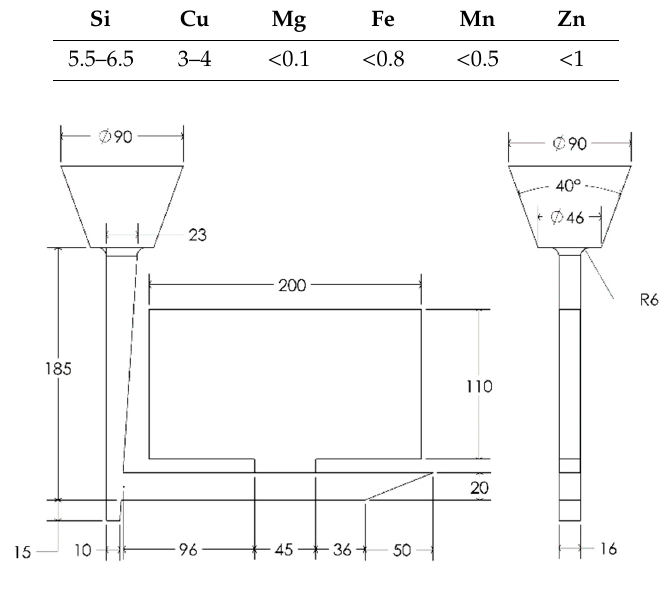
Table 1. Chemical composition of 319 aluminum alloy in wt.%.